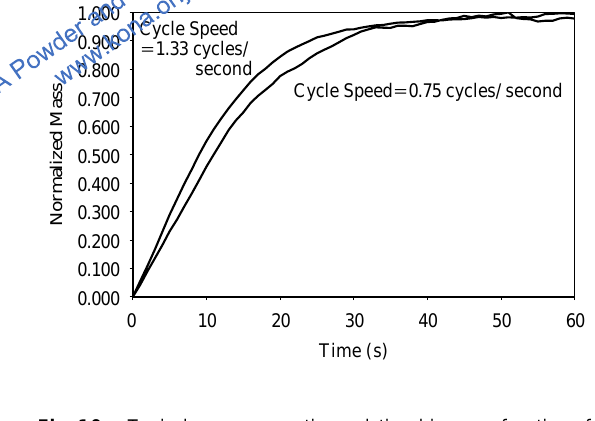
Fig. 10 Typical mass versus time relationships as a function of cycle speed (cid:4) Size Ratio (cid:6) 10.9:1, Strain (cid:6) 15%, Bed Depth (cid:6) 7.62